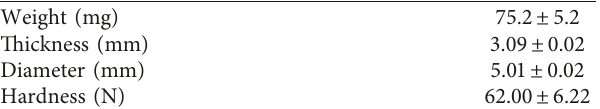
Table 1: Measured characteristics of the tablets—average values for 20